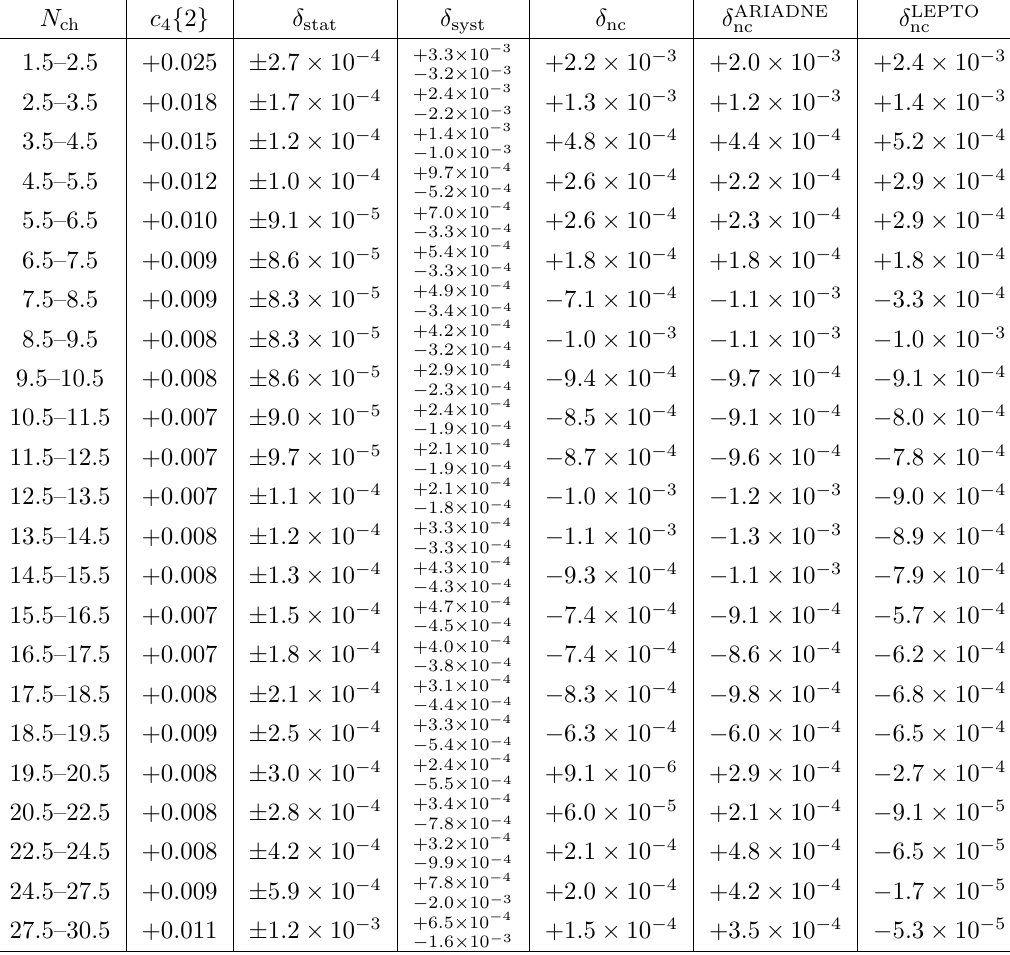
Table 10 . c 4 f 2 g versus N ch from (cid:12)gure 7 (d), p T > 0 : 1 GeV, no j (cid:1) (cid:17) j cut; (cid:14) stat , (cid:14) syst and (cid:14) nc denote the statistical, systematic and Monte Carlo non-closure uncertainties,